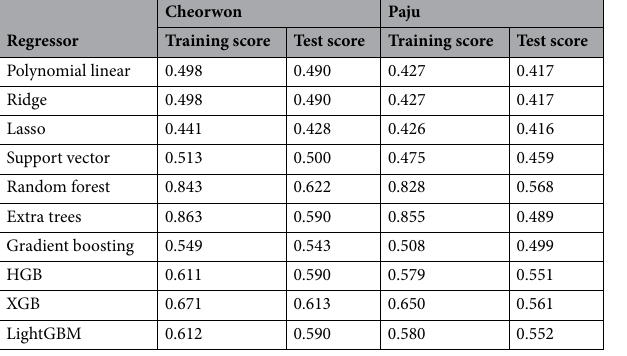
Table 1. Training and test scores for regression analyses of leaf area index (LAI) with respect to climate factors using 10 machine learning (ML) regressors for rice in Cheorwon and Paju, South Korea. HGB, XGB, and LightGBM stand for Histogram-based Gradient Boosting, Extreme Gradient Boosting, and Light Gradient Boosting machine